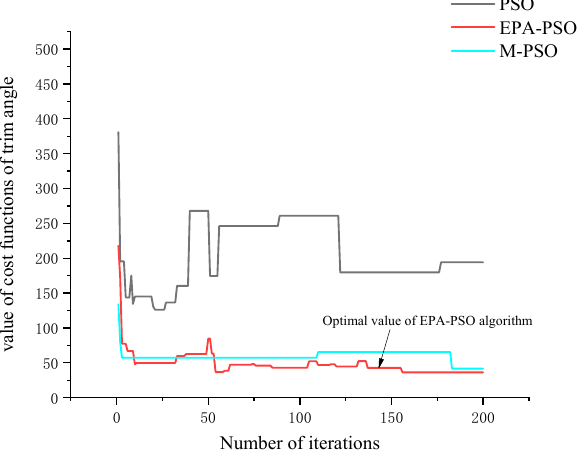
Figure 19. Numerical comparison of cost functions of trim angle after 100 iterations.